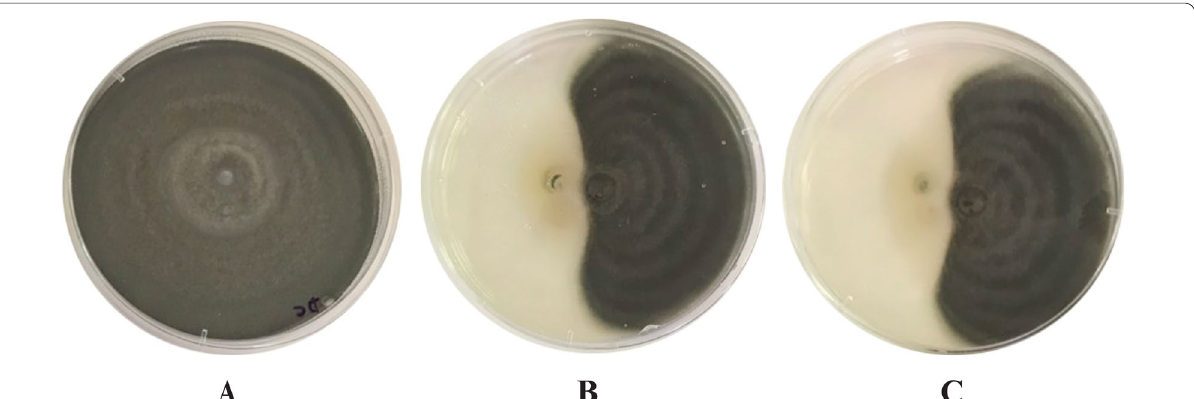
Fig. 1 Endophytic bacteria inhibited the mycelial growth of Magnaporthe oryzae . ( A ) A. alternata YZU growth alone. ( B ) The antagonistic effect of ND06 against M. oryzae and ( C ) Antagonistic activity of ND10 isolates against M. oryzae